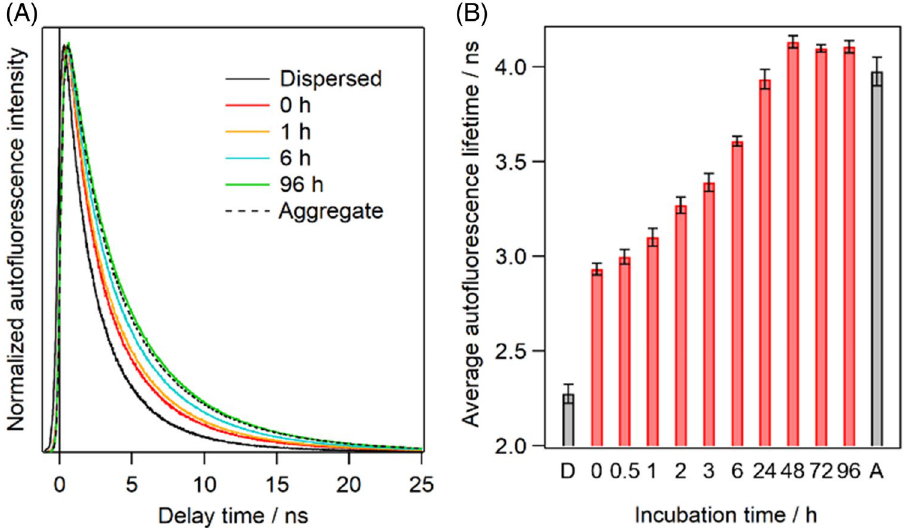
Figure 2. ( A ) Normalized autofluorescence decay curves and ( B ) average autofluorescence lifetimes of Q28 in the dispersed solution, the droplets, and the aggregates. In ( A ), coloured solid curves are the autofluorescence decay curves of the droplets at various incubation times. Black solid and broken curves are the autofluorescence decay curves of the dispersed solution and the aggregates, respectively. In ( B ), red bars are the average lifetimes of the droplets at various incubation times. Values below the bars are the incubation times in hours. “D” and “A” below the bars represent the dispersed solution and the aggregates, respectively. Error bars are SD (The numbers of replicates are summarized in Table